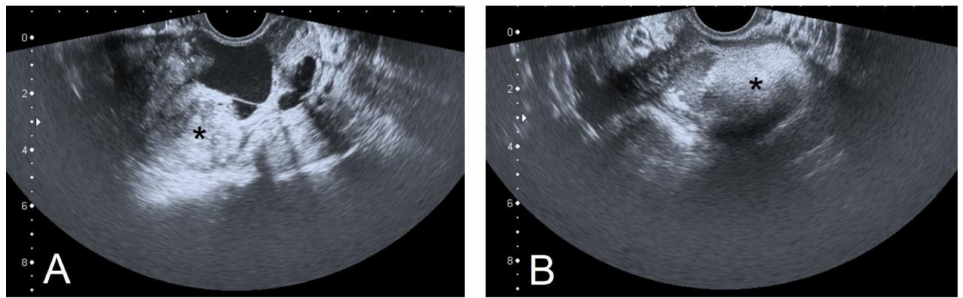
Figure 4. Transvaginal ultrasound examination of the left ovarian struma (2016) (( A , B ); *: tumor; previously unpublished, original photos).